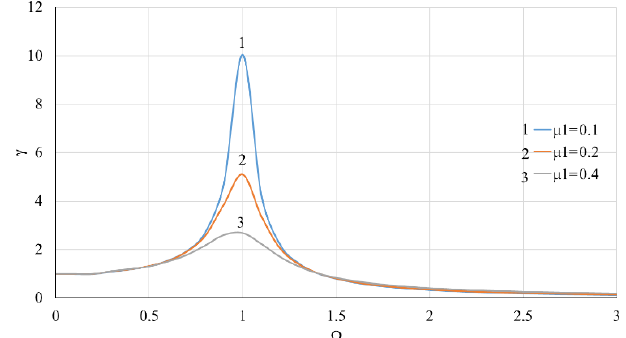
Figure 4. Dependence of the vibration amplitude A on the rotor velocity (cid:127) with linear stiffness of the support and at different values of the coefficient of linear viscous damping µ 1 .